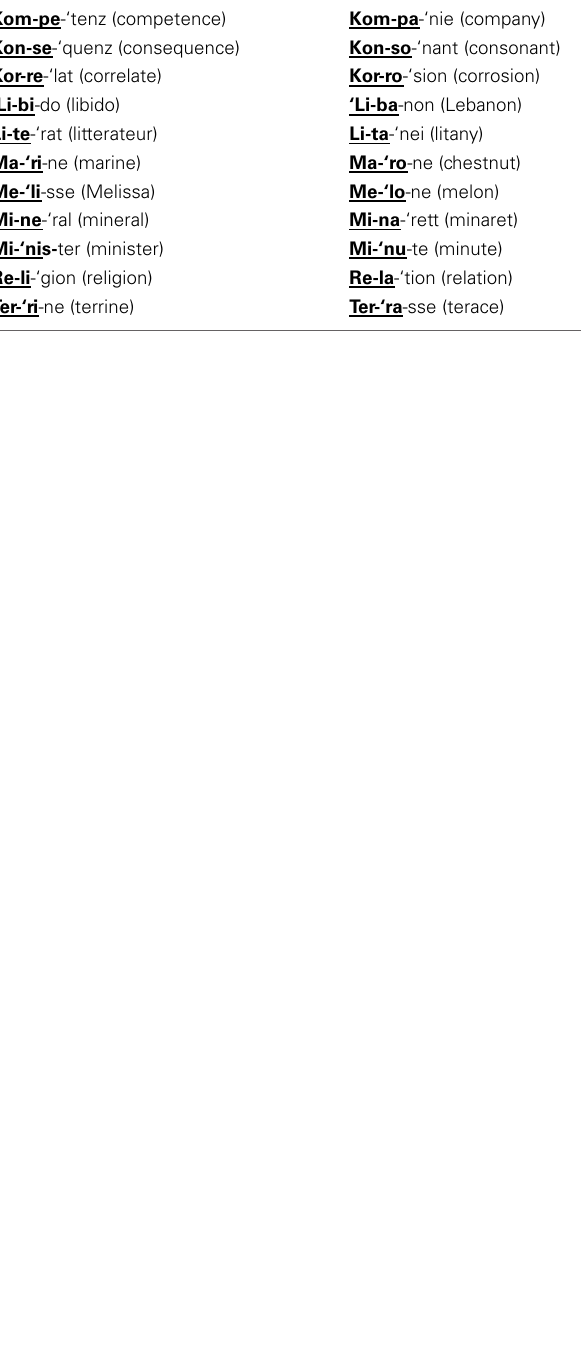
List of the German word pairs (with English translation) used as target words and for the primes. Syllable boundaries are marked by a dash, with ambisyllabic elements given in italics. The onset of the stressed syllable is marked by an apostrophe. Primes represented the word onset up to the first phoneme that distin- guished both words within a pair. The prime string that was taken from the spoken form of a respective word is bold and